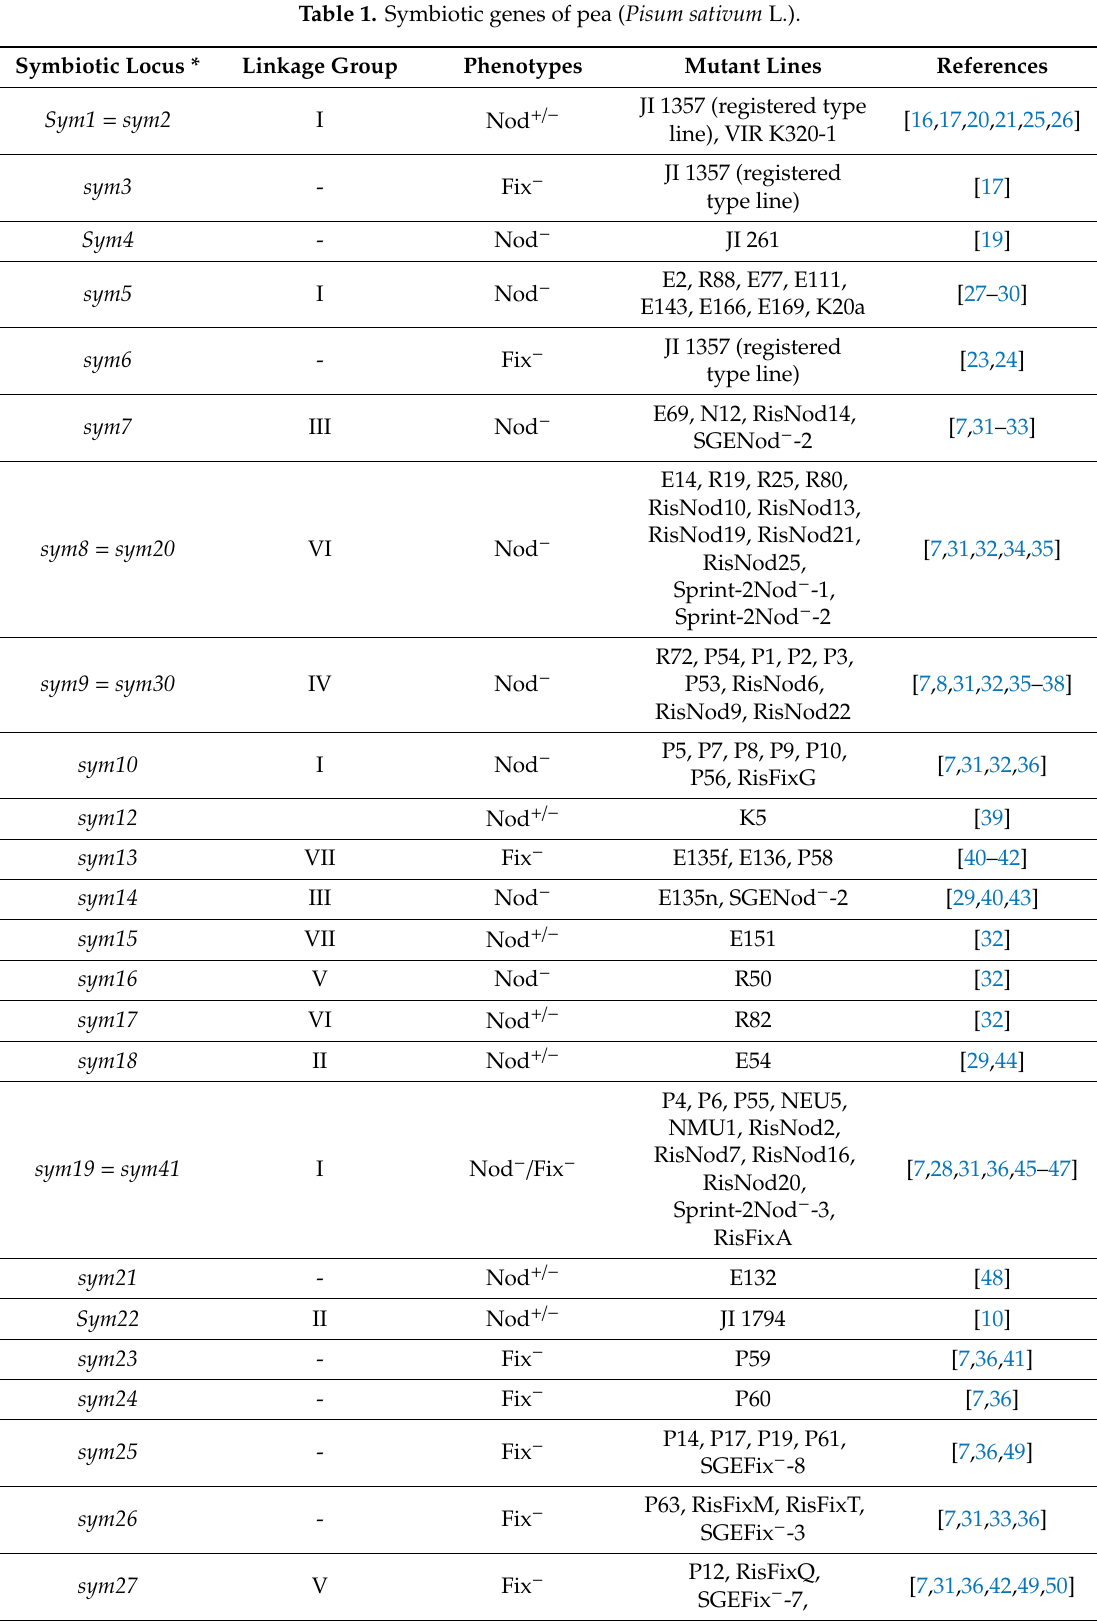
Table 1. Symbiotic genes of pea ( Pisum sativum